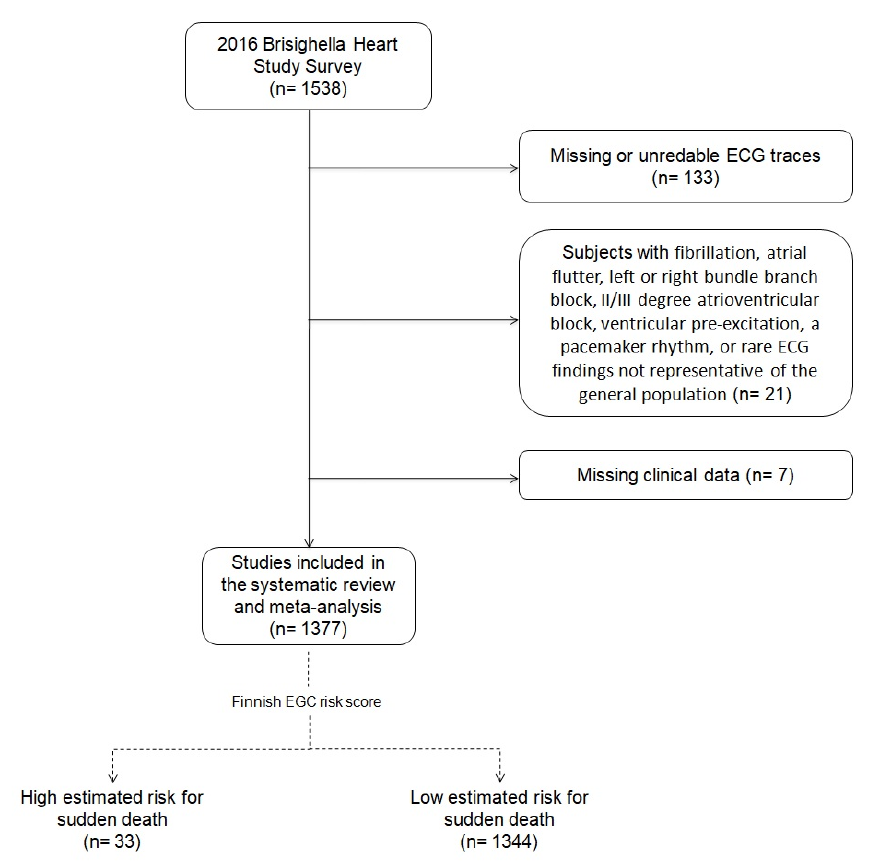
Figure 1. Flow-chart resuming the selection criteria applied to the full cohort to select the investi- gated subjects.